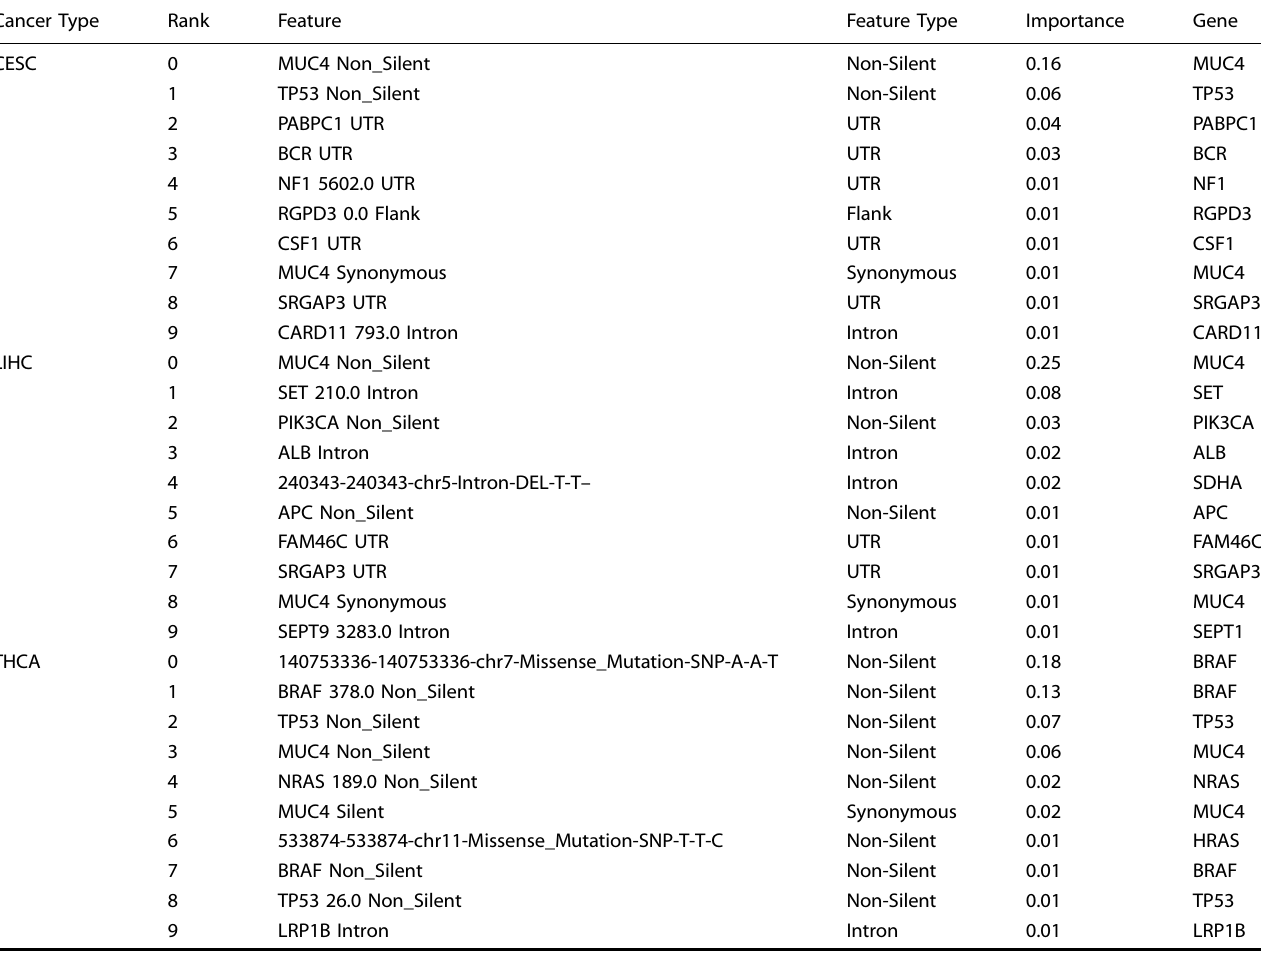
Table 1. Examples of the top 10 ranked features for classifying various cancer types. Cancer